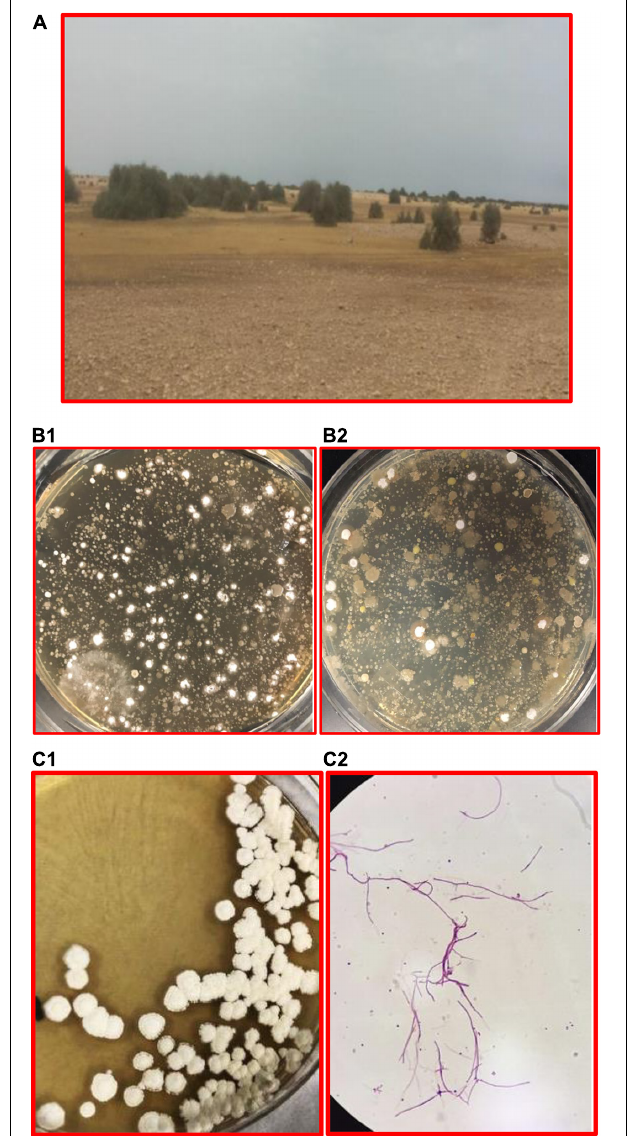
FIGURE 4 | Streptomyces is found at various Qatari lands. (A) The site of study at a Rawdah, (B1) control soil sample from a Rawdah (non-rhizospheric), the bacteria count = 2.75 × 10 3 cfu/g dry soil, (B2) soil sample collected from under the canopy of the tree at the same location, the bacteria count = 7.5 × 10 2 cfu/g dry soil. (C1) Pure cultures of Streptomyces , (C2) filaments of Streptomyces , Gram-positive, magnification of 100 × . From figures (B1,B2) : the white colonies represent the Streptomyces colonies; more Streptomyces bacteria are found at (B1) than (B2) . However, in